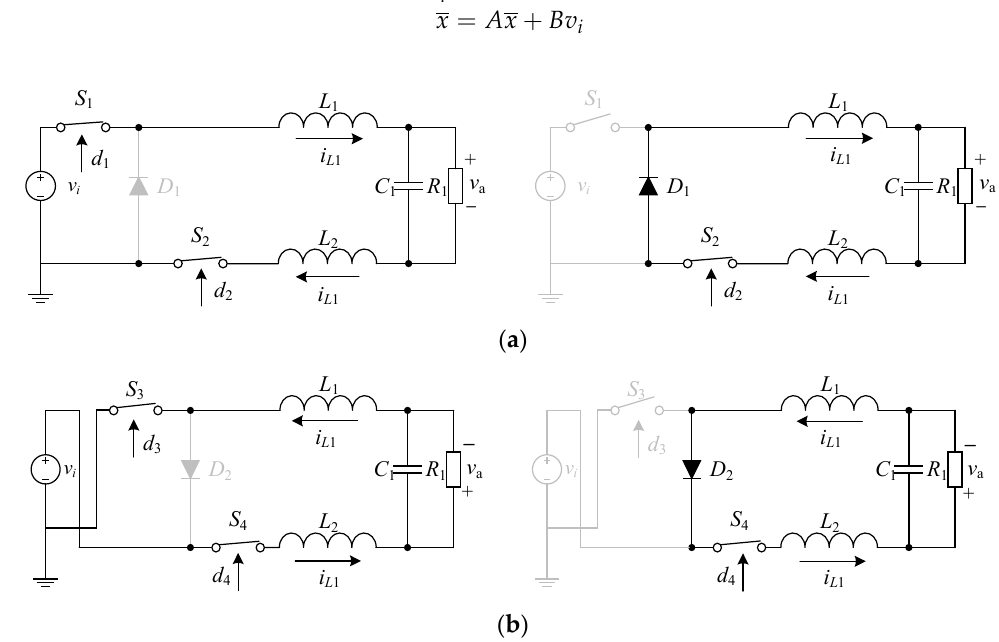
Figure 8. Switch status in AC mode. ( a ) AC mode (+) switch status, ( b ) AC mode ( − ) switch status.